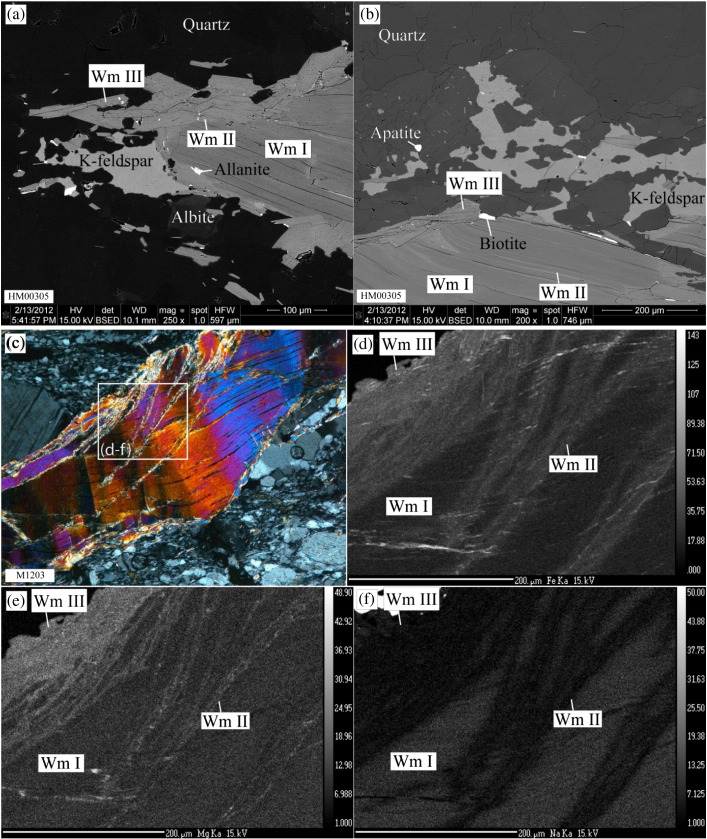
(a–b) BSE images of sample HM00305 showing the different muscovite groups (Wm I–III), their inclusions and the related syntectonic phase assemblage including WM III. (c) Photomicrograph with crossed polarised light showing a kinked and fractured Ms-clast of sample M1203. (d–f) Quantitative element maps showing (d) Fe- ,(e) Mg- and (f) Na-distribution in the area highlighted in panel (c). (g–h) Quantitative element maps of a mm-sized Permian muscovite clast from sample M1217 showing (g) Fe- and (h) Mg-distribution related to the different muscovite groups. Note, the weak compositional difference between Wm II associated with the clast-internal domain (crack) and the Wm II along the rims, possibly representing different generations of Wm II. (i) Detailed BSE-image of a sharp transition front between Wm I and Wm II (head of black arrow) in sample HM00305.